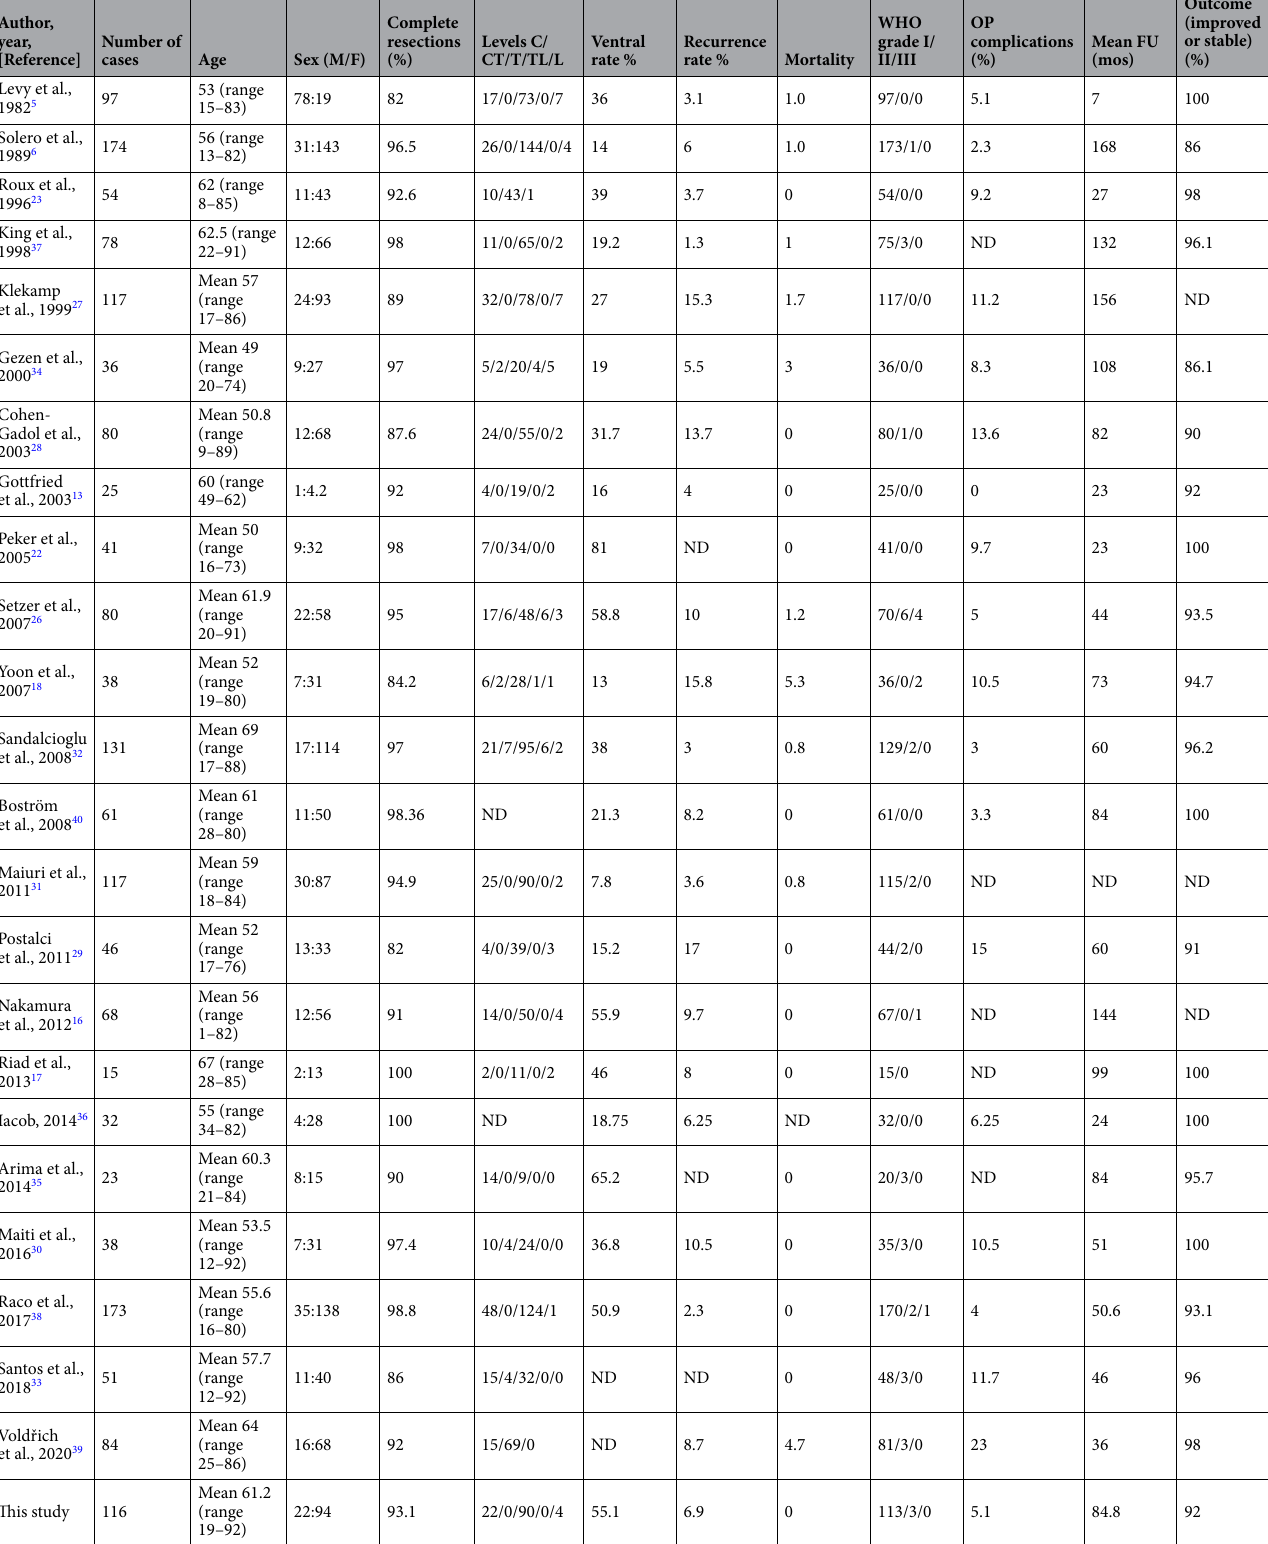
Table 6. Literature review of spinal meningioma. C cervical, CT cervicothoracic, T thoracic, TL thoracolumbar, L lumbar, ND no